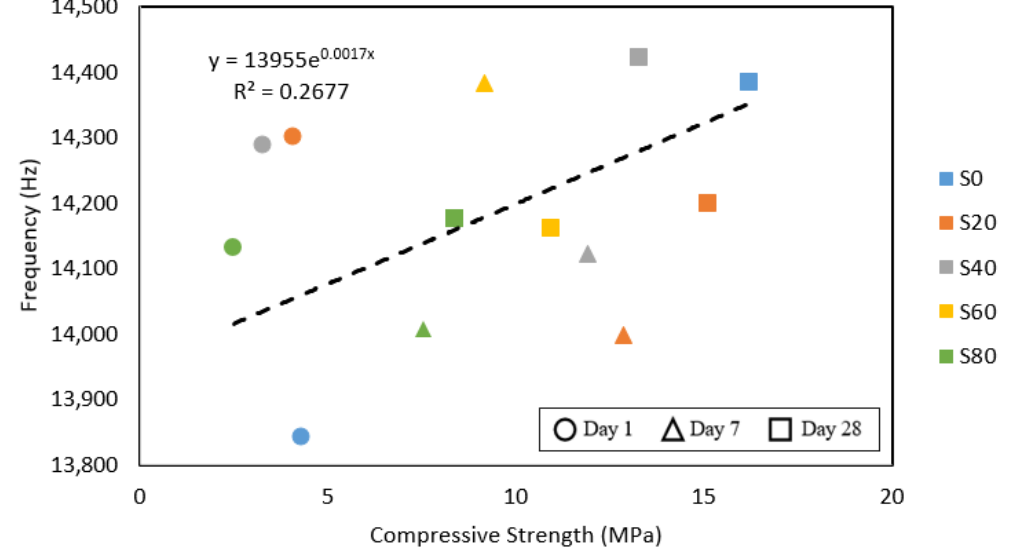
Figure 7. Correlation between P-wave dominant frequency and the concrete compressive strength of all mix proportions on day-1, day-7 and day-28 maturity ages